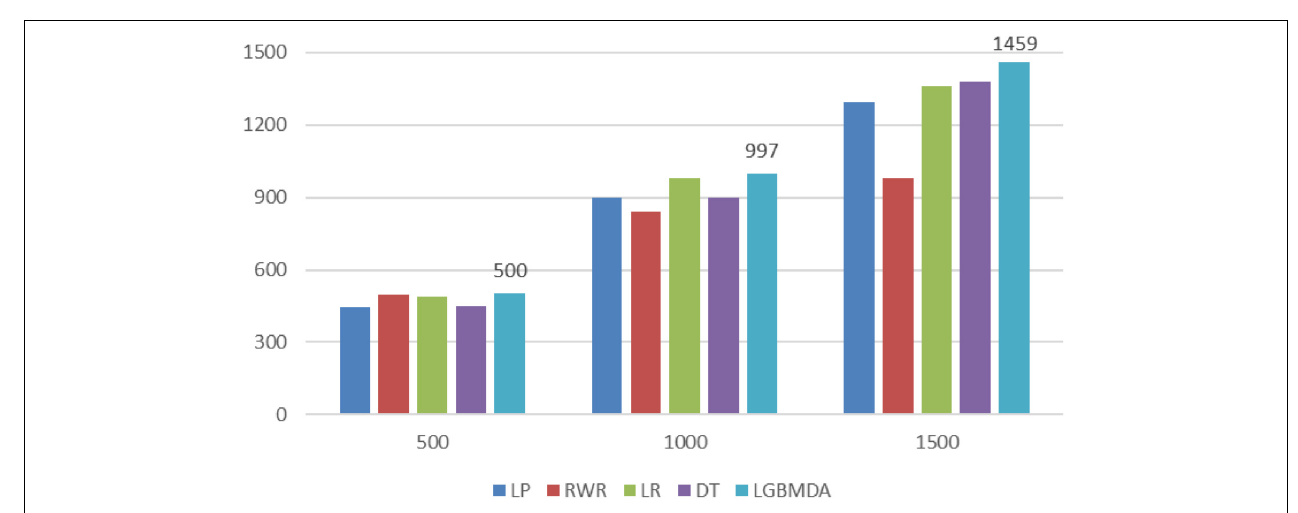
FIGURE 4 | The ROC about fivefold cross validation.